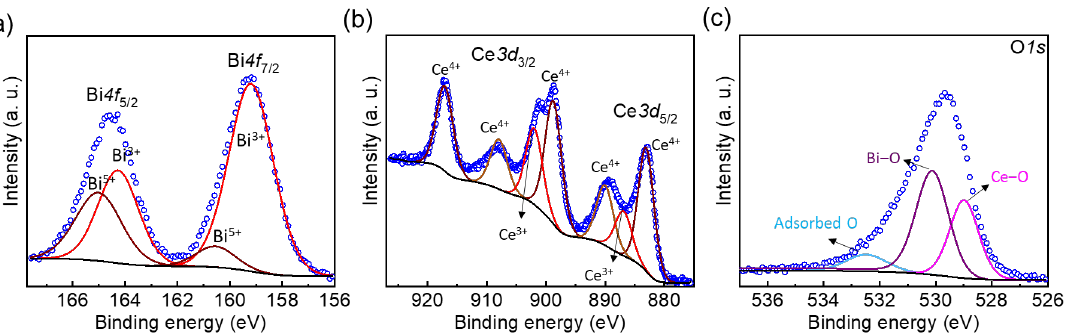
Figure 4. XPS analysis at high resolution for Bi 4f ( a ), Ce 3d ( b ), and O 1s ( c ) of the 15% Bi 2 O 3 /CeO 2 heterojunction.